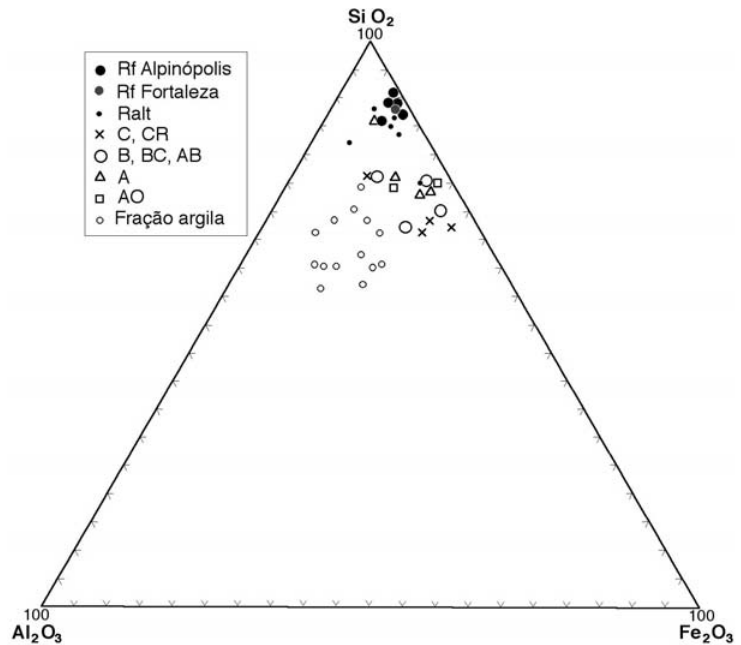
4. Variação dos componentes do Sistema Residual (Chesworth, 1973), nos diferentes estádios de alteração e ganhos (balanço iso-alumínio) dos componentes majoritários nos perfis